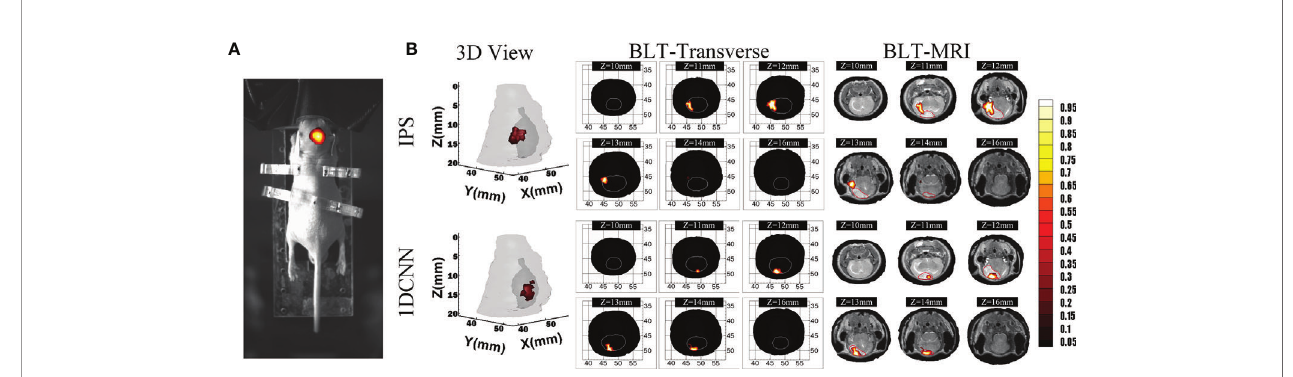
FIGURE 6 | Reconstruction results in in vivo experiments. (A) The fusion image of the white light image and BLI. (B) The 3D view and several transverse section images of BLT reconstruction results and merged images of BLT and MRI data, where the MRI highlight region contour is drawn in red line.